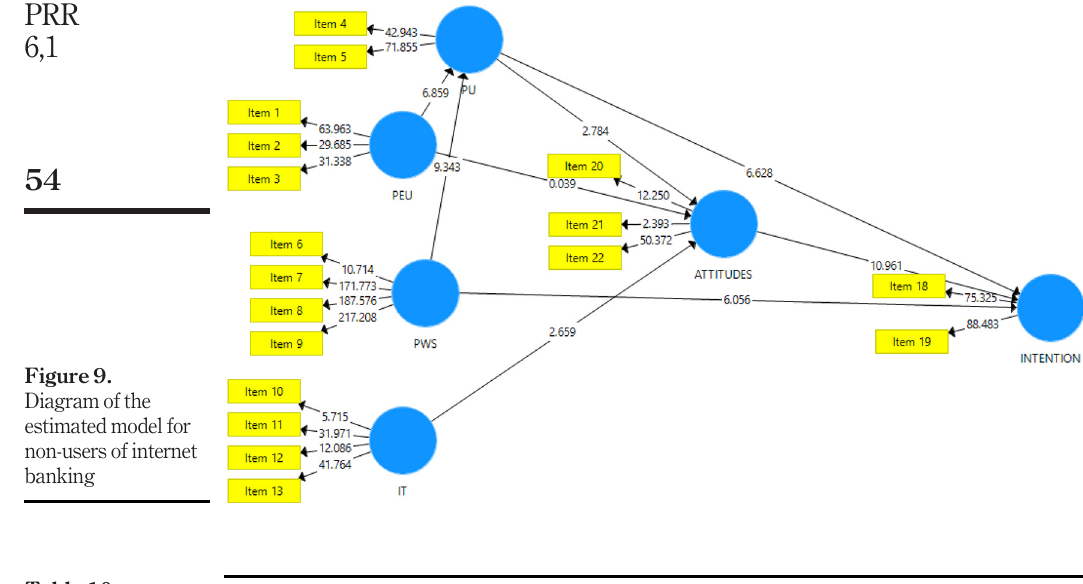
Table 10. Predictive power of the estimated model for users of internet banking